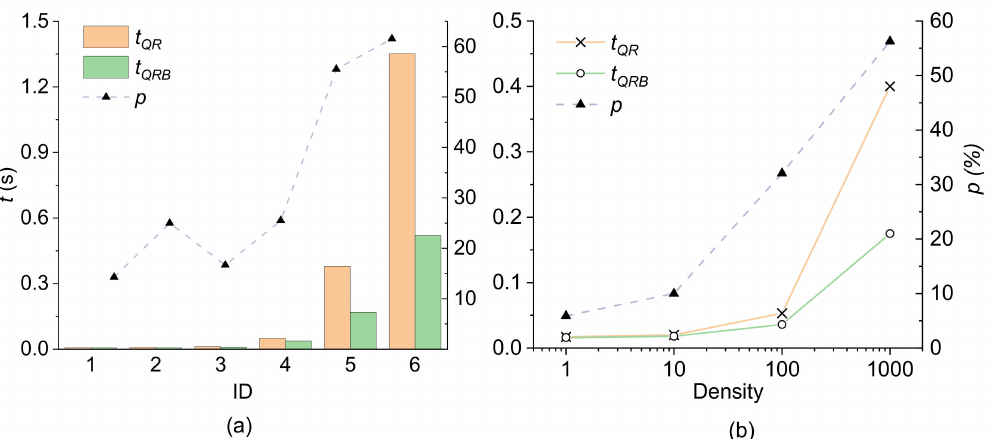
Figure 11. Comparison of the time cost ( t ) associated with the QR-tree index ( t QR ) and QRB-tree index ( t QRB ) for testing on the simulated datasets. The percentage of improvement ( p ) for the QRB-tree index over the QR-tree index, calculated as (cid:0) (cid:1) t QR − t QRB / t QR , is shown on the right axis. ( a ) Time costs against the IDs of the first five rectangles shown in Figure 6a. The last rectangle in Figure 6a is excluded because its time cost for the QR-tree index is too large for the others to be clearly shown. ( b ) Time costs of region queries against the feature density, which is defined by the number of features per unit